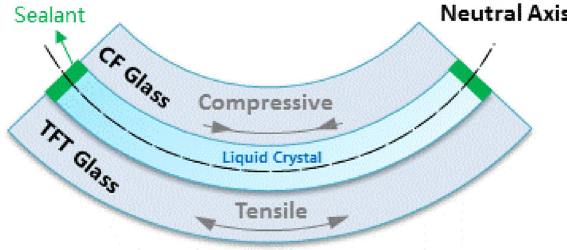
Figure 1. Diagram of panel bended.